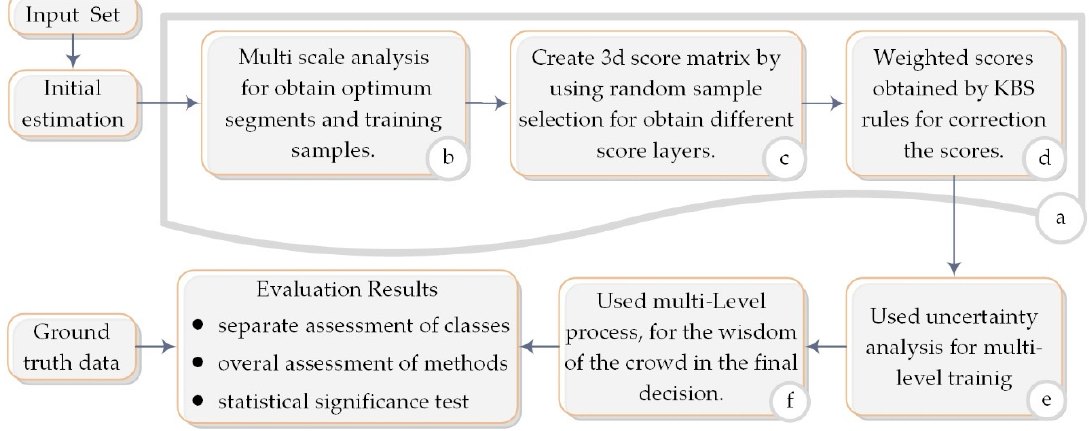
Figure 1. Workflow of the proposed method.